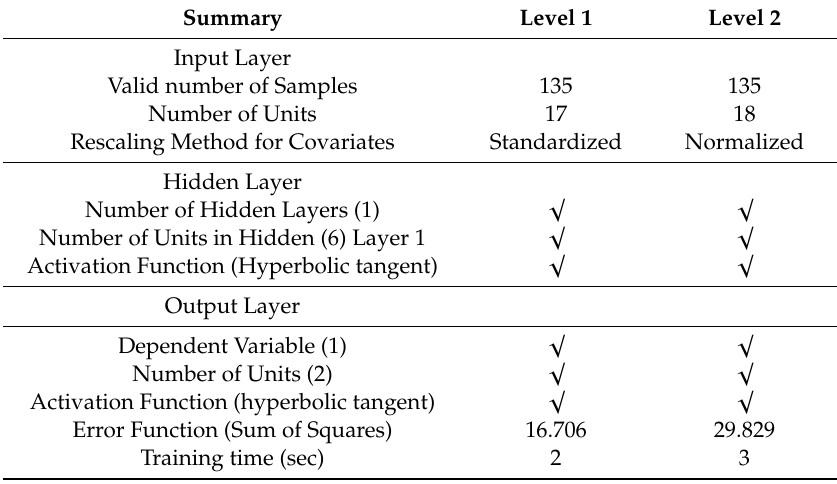
Table 2. Network information for two training and testing sessions excluding